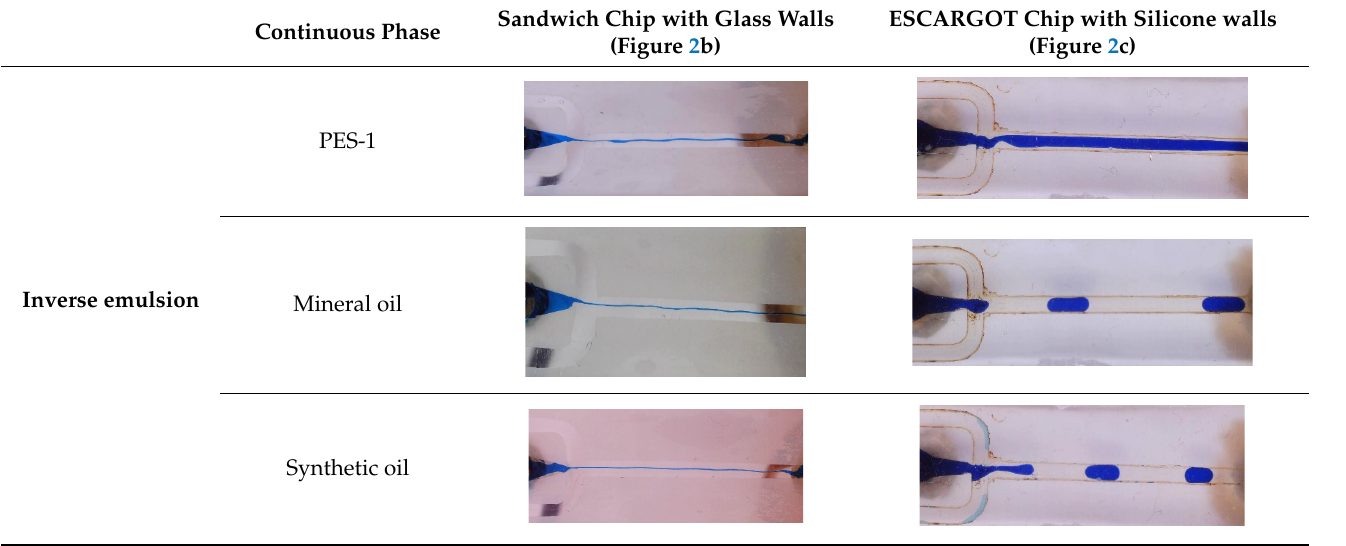
Table 3. The effect of the chip wall material on the formation of droplets in the microchannel.